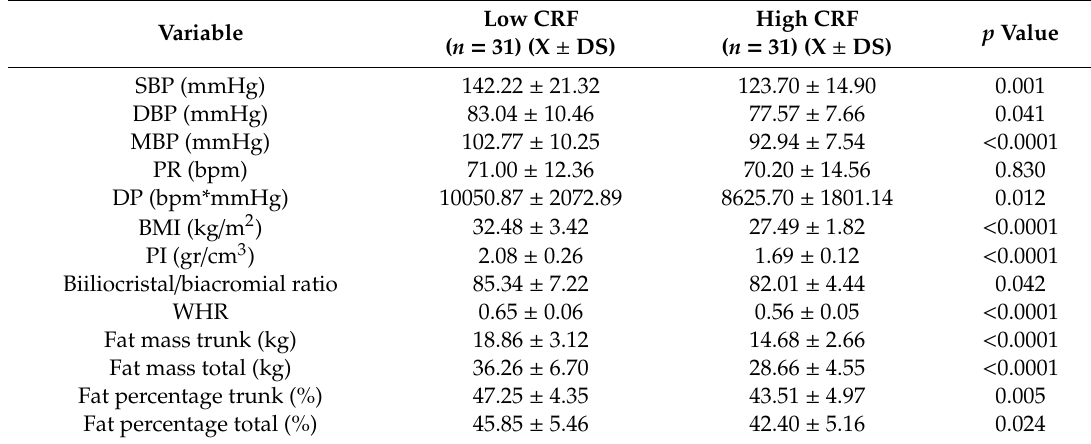
Table 4. Cardiovascular, proportionality, and body composition variables according to cardiorespiratory fitness (CRF).